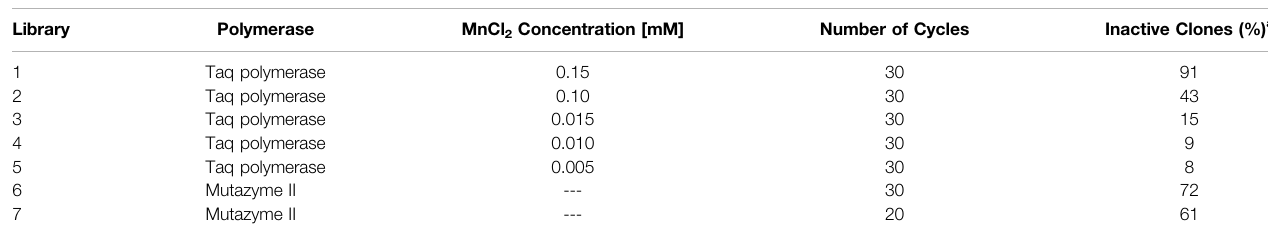
TABLE 1 | Mutagenic conditions for the construction of mutant libraries.